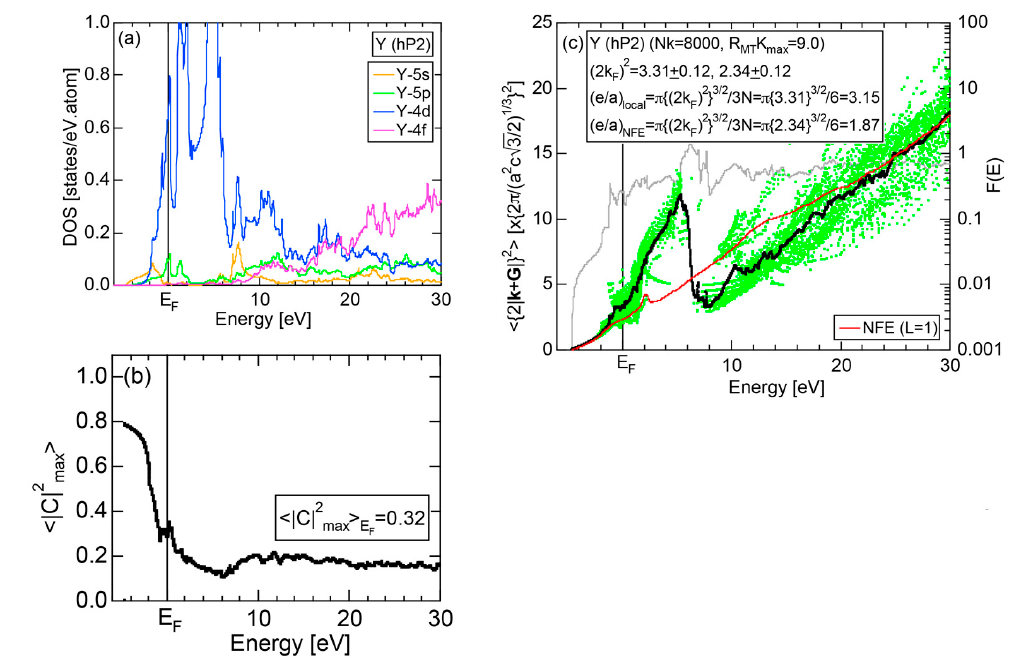
Figure 93. ( a ) Y-partial DOSs, ( b ) C max and ( c ) Hume-Rothery plot for Y (hP2). See captions of Figure 19 (b) for symbols in (c) [11,15,16,37]. Two distinct e/a values are obtained for Y (hP2), depending on either the local reading or the NFE method.